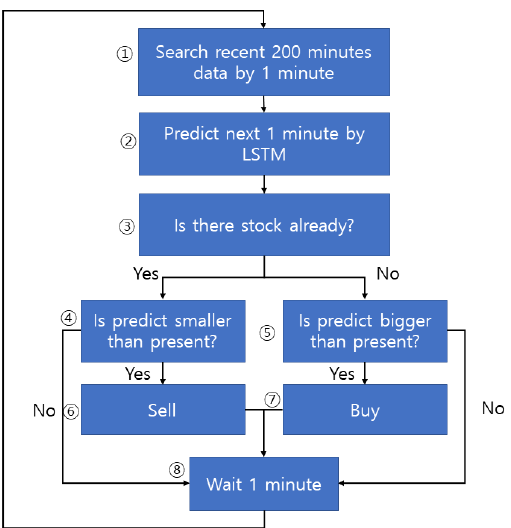
Figure 4. Cryptocurrency time series analysis algorithm in 1 min units using LSTM.